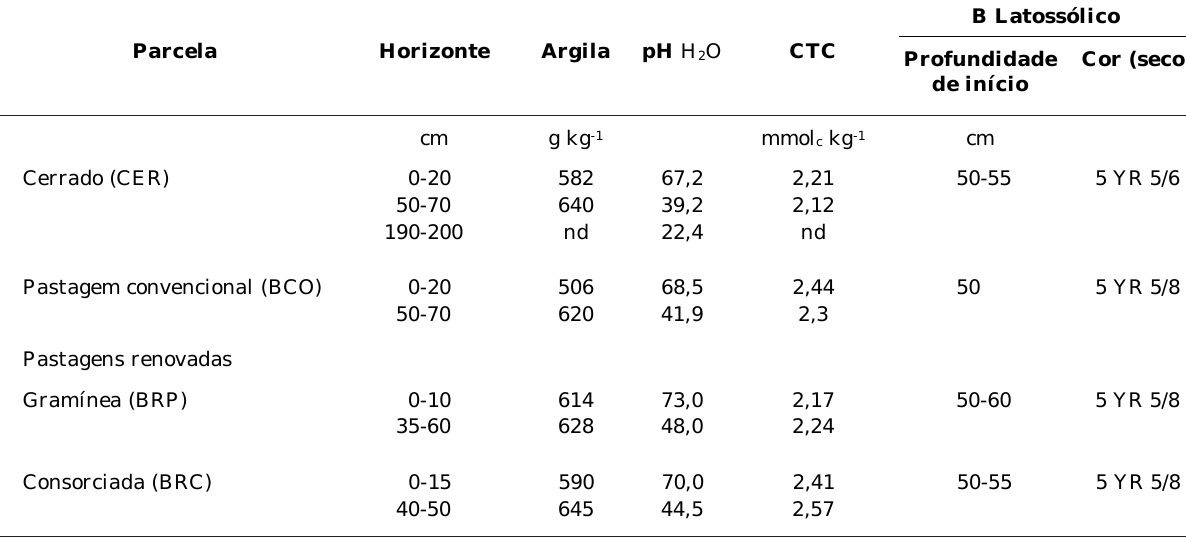
(Figura 2) e dos resultados de estabilidade de agregados (Figura